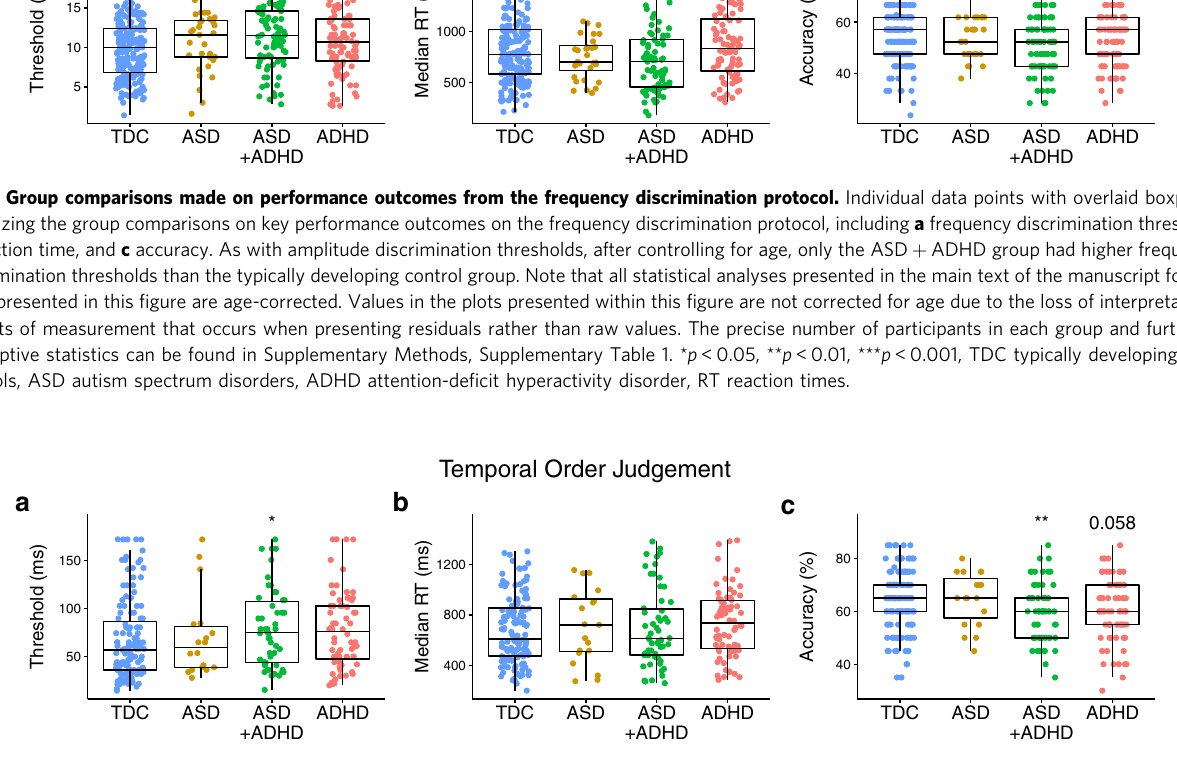
Fig. 5 Group comparisons made on performance outcomes from the temporal order judgement protocol. Individual data points with overlaid boxplots visualizing the group comparisons on key performance outcomes on the temporal order judgement protocol, including a order judgement threshold, b reaction time, and c accuracy. While it would appear that only the ASD + ADHD and ADHD groups had elevated order judgement thresholds compared to the typically developing control group, after controlling for age, only the ASD + ADHD group had higher order judgement thresholds compared to controls. However, when looking at accuracy, the ASD + ADHD and ADHD group showed signi fi cant and a non-signi fi cant trend towards being less accurate than the typically developing control group (respectively). Note that all statistical analyses presented in the main text of the manuscript for the plots presented in this fi gure are age-corrected. Values in the plots presented within this fi gure are not corrected for age due to the loss of interpretability of units of measurement that occurs when presenting residuals rather than raw values. The precise number of participants in each group and further descriptive statistics can be found in Supplementary Methods, Supplementary Table 1. * p < 0.05, ** p < 0.01, *** p <